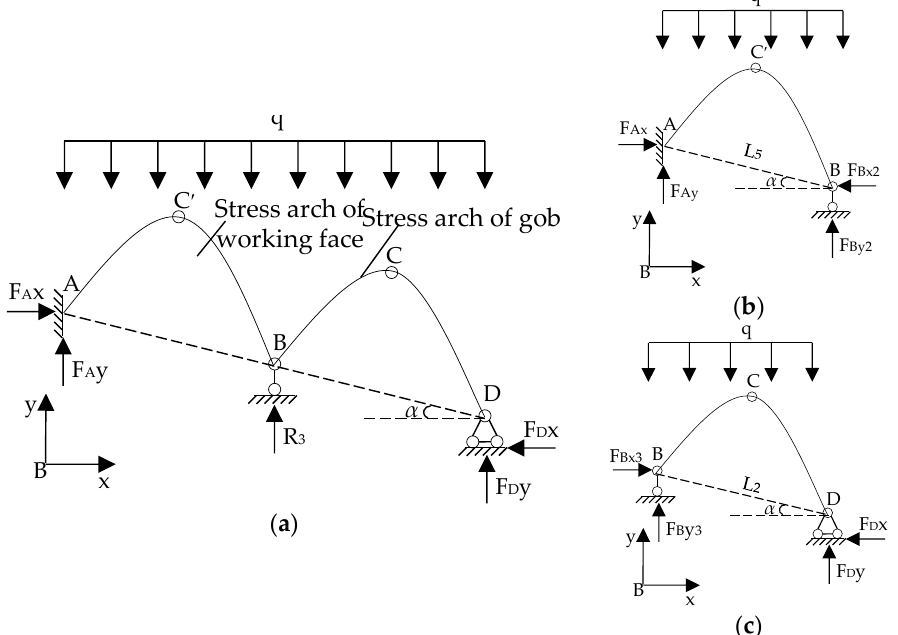
Figure 5. Roof inclined fracture structure of long width working face. ( a ) Mechanical model of multi-articulated–multi-articulated structure; ( b ) multi-articulated left end structural isolator; ( c ) multi-articulated right end structural isolator.